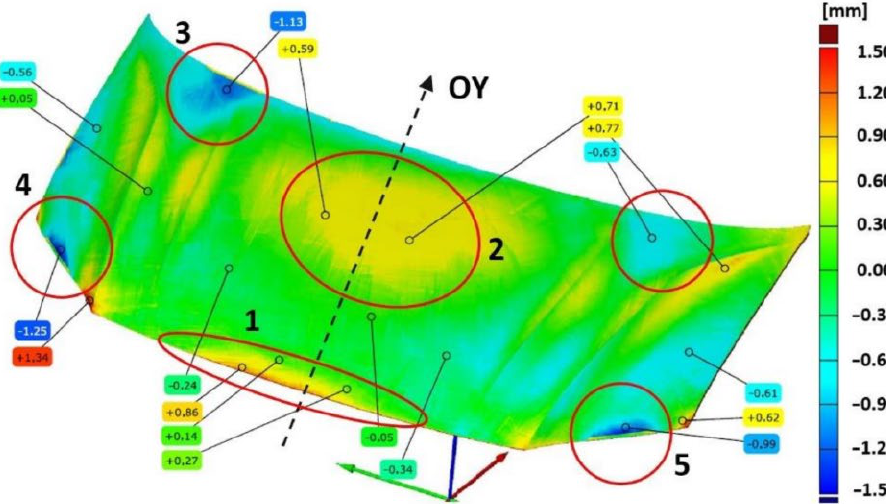
Figure 15. Optimization of product development based on contrast detection [44].